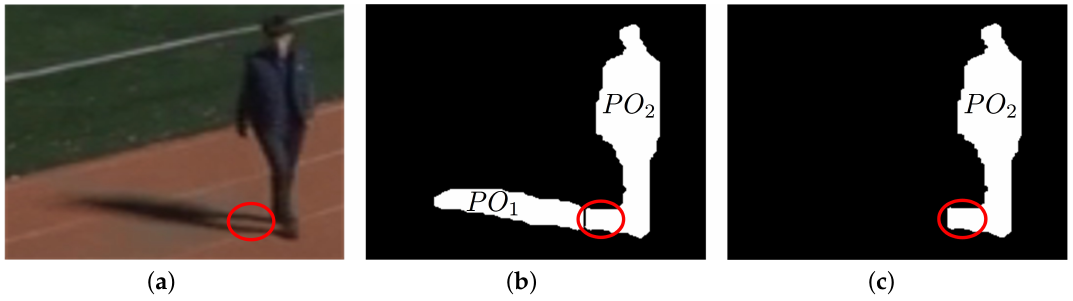
Figure 13. Shadow removal result 2 for a foreground object (87 × 84 pixels from sequence S3): ( a ) A foreground object; ( b ) Partitioned objects; ( c ) A foreground object after shadow